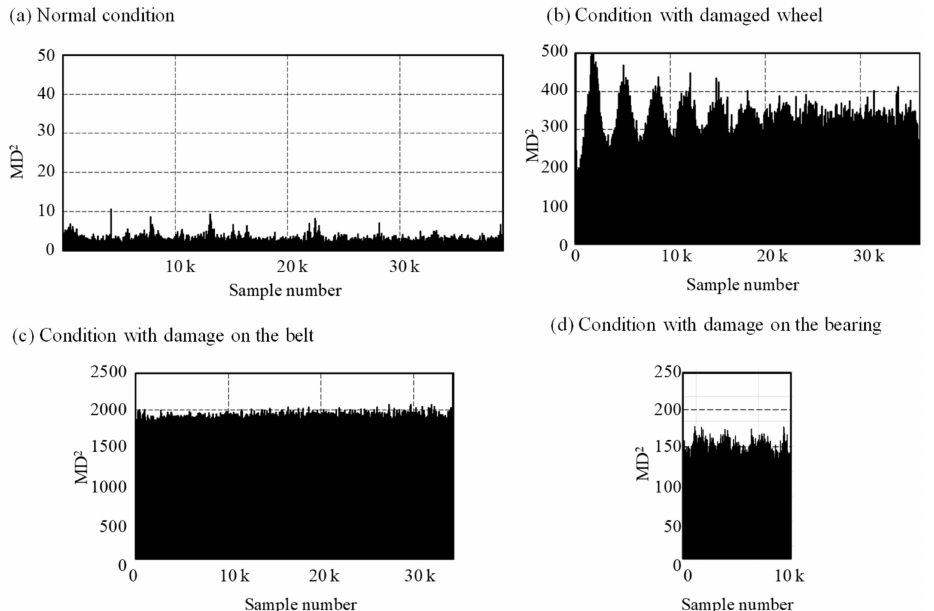
Figure 22. MD 2 of the time-series data under the ( a ) normal condition and conditions damaged with the ( b ) guide wheel, ( c ) belt, and ( d ) bearing, respectively: These results in all of damaged three